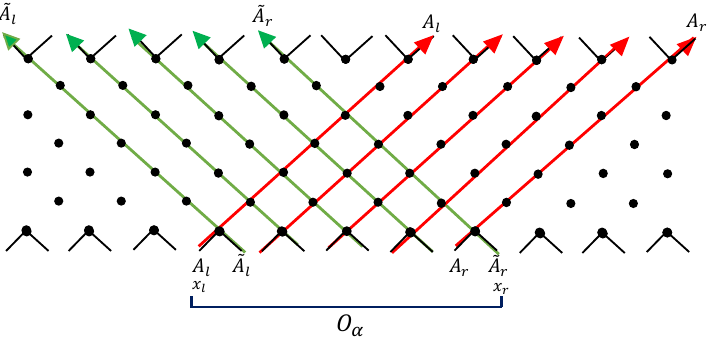
Figure 12 . Growth of an operator O α in I . Any operator in I has its left endpoint at an even site x l and its right endpoint at an odd site x r . The evolution of operators follows (4.5) with operators at even (odd) sites moving right (left), which are shown respectively using red and green. At time t , the left and right endpoints are at x l − ( t − 1) and x r + ( t − 1) respectively (for sufficiently large times we have t − 1 ≈ t ). The resulting operator has a central void of length 2 t − L i , where L i is the length of the initial operator, as well as other voids of length 1 . The number of sites with non-trivial operators remains fixed as a function of time.